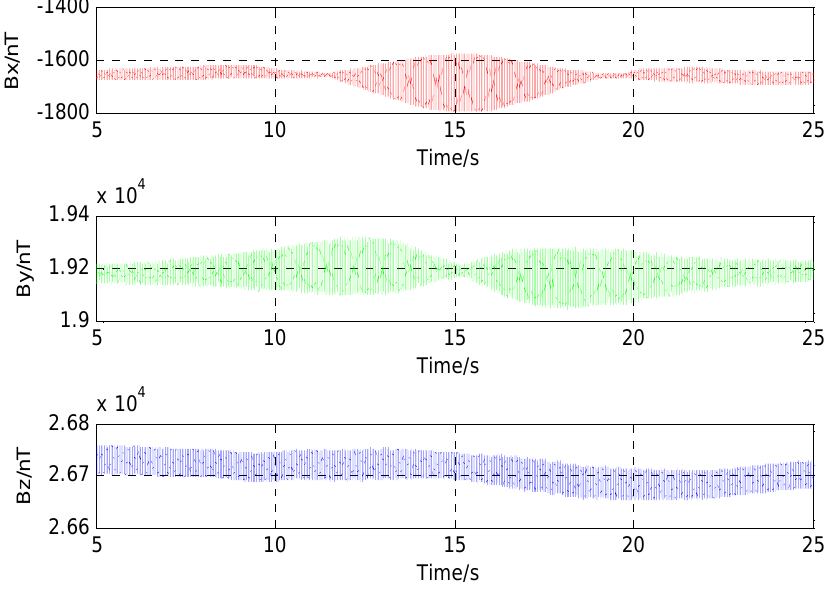
Figure 11. Magnetic field data acquired by three-component fluxgate sensor.